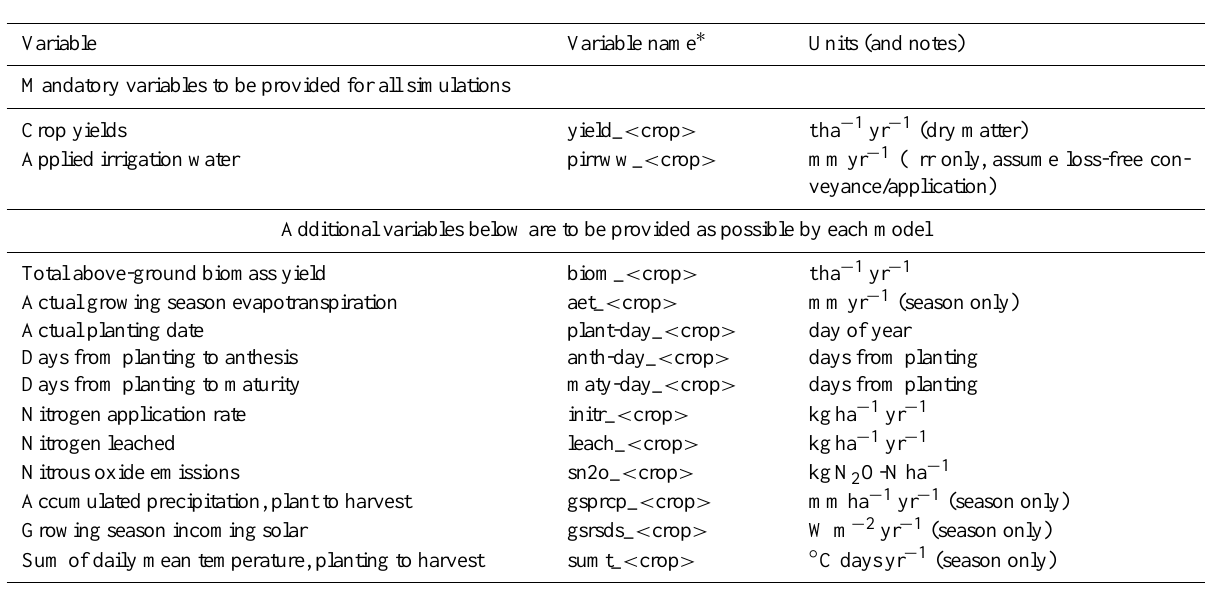
Table 4. Output variables to be collected during GGCMI Phase 1. The first two variables are to be provided by every model; other variables are to be provided as possible by each